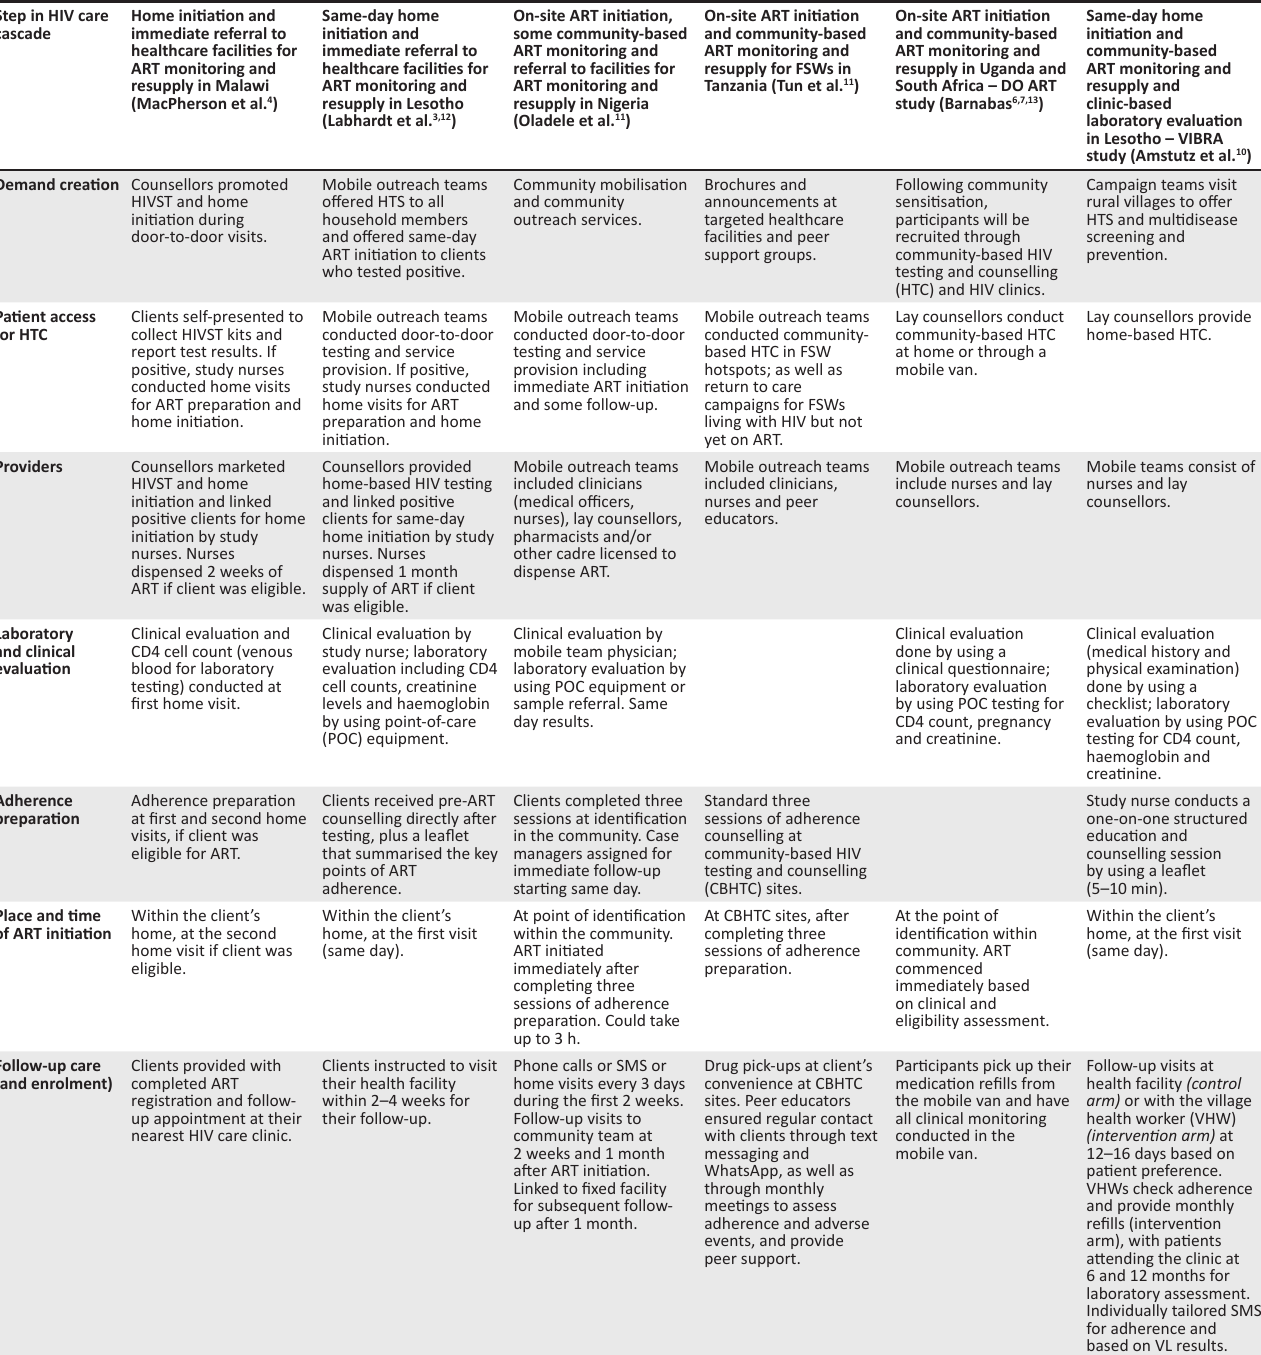
TABLE 2: Comparative summary of community antiretroviral therapy initiation models identified. Step in HIV care Home initiation and cascade immediate referral